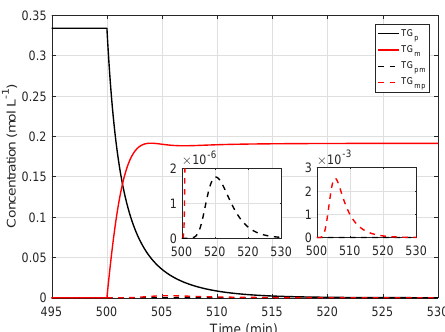
Figure 6. Triglycerides from palm oil, mustard oil, and formed in the cross-linking reactions after the change from palm to mustard